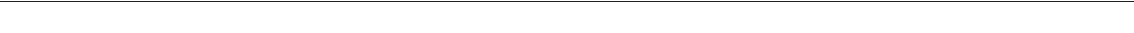
Fig. 7 Human UC-MSC treatment preserves mitochondrial function and tubulin-dependent exchange by regulating SIRT3 targets in renal tissue of AKI mice. a Evaluation of ATP and b NAD + content in renal tissue from control and cisplatin mice (NOD/SCID) given saline or UC-MSCs at 4 days ( n = 4 mice per group). *** P < 0.001 vs Control and ° P < 0.05, °°° P < 0.001 vs Cispl using ANOVA corrected with Bonferroni coef fi cient. c Densitometric analysis of protein acetylation in mitochondria isolated from renal tissue of control and cisplatin mice given saline or UC-MSCs at 4 days ( n = 3 mice per group). ** P < 0.01 vs Control and ° P < 0.05 vs Cispl using ANOVA corrected with Bonferroni coef fi cient. d Quanti fi cation of SOD2 protein expression (red) in proximal tubuli of control and cisplatin mice given saline or UC-MSCs at 4 days ( n = 6 mice per group). *** P < 0.001 vs Control and °°° P < 0.001 vs Cispl using ANOVA corrected with Bonferroni coef fi cient. e Representative images showing that in proximal tubuli of cisplatin mice at 4 days, the expression of SOD2 (red) and tubulin (green) was decreased and their distribution was markedly altered in respect to control animals; both proteins were normalized by UC-MSCs. The tubuli are labeled with wheat germ agglutinin (WGA) lectin (white), and nuclei with DAPI (blue). Scale bar 10 μ m. f Representative western blots and densitometric analysis of tubulin, g acetylated tubulin, and h Kif5c protein expression in renal tissue of control and cisplatin mice given saline or UC-MSCs at 4 days ( n = 4 mice per group). * P < 0.05, *** P < 0.001 vs Control and ° P < 0.05, °° P < 0.01, °°° P < 0.001 vs Cispl using ANOVA corrected with Bonferroni coef fi cient. i Representative immuno fl uorescence images of SOD2 (red) and tubulin expression (green) in proximal tubuli of untreated wild-type (WT) littermates that markedly changed in SIRT3-de fi cient (SIRT3 − / − ) mice. Tubuli are identi fi ed with WGA lectin (white) and nuclei with DAPI (blue). Scale bar 10 μ m. j Scanning electron microscopy micrographs showing the lumen of proximal tubuli of untreated WT littermates and SIRT3 − / − mice. No nanotube-like structures were observed in untreated SIRT3 − / − mice. Cisplatin affected nanotube-like structures in tubuli of WT mice that were restored by UC-MSCs at variance with SIRT3 − / − cisplatin mice that did not respond to UC-MSCs. Scale bar 4 μ m. Data in a – d and f – h are expressed as mean ±